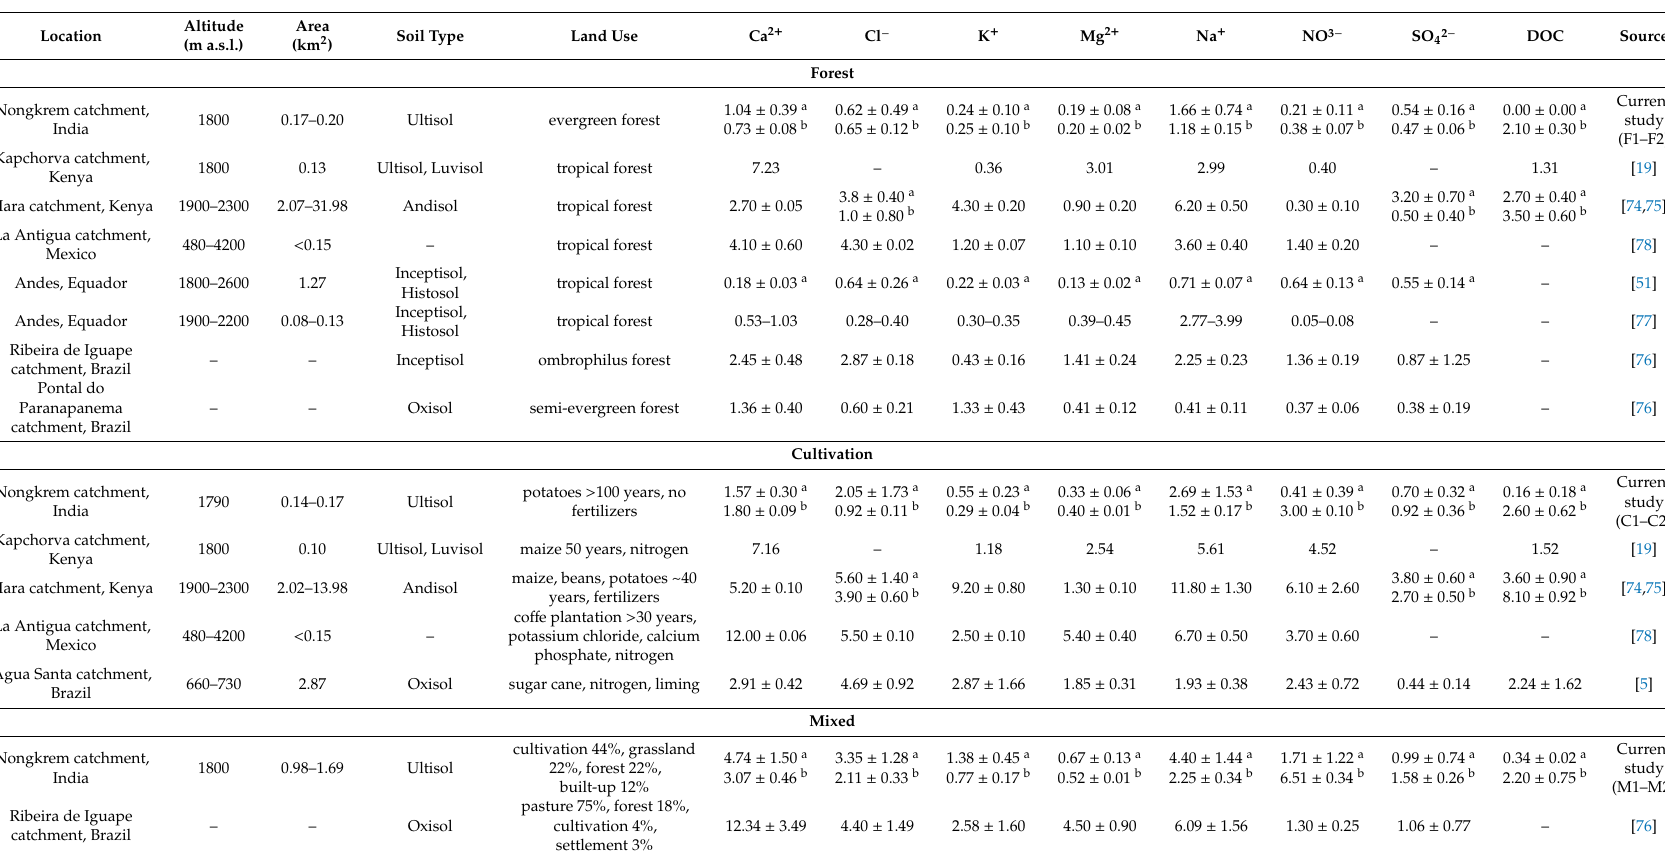
Table 6. Selected chemical element concentrations in tropical headwater catchments with natural forest, cultivation, and mixed land use. Values represent mean ( ± SD) concentrations or the range for particular land use. a—concentrations during dry season, b—concentrations during wet season, and —–no data.